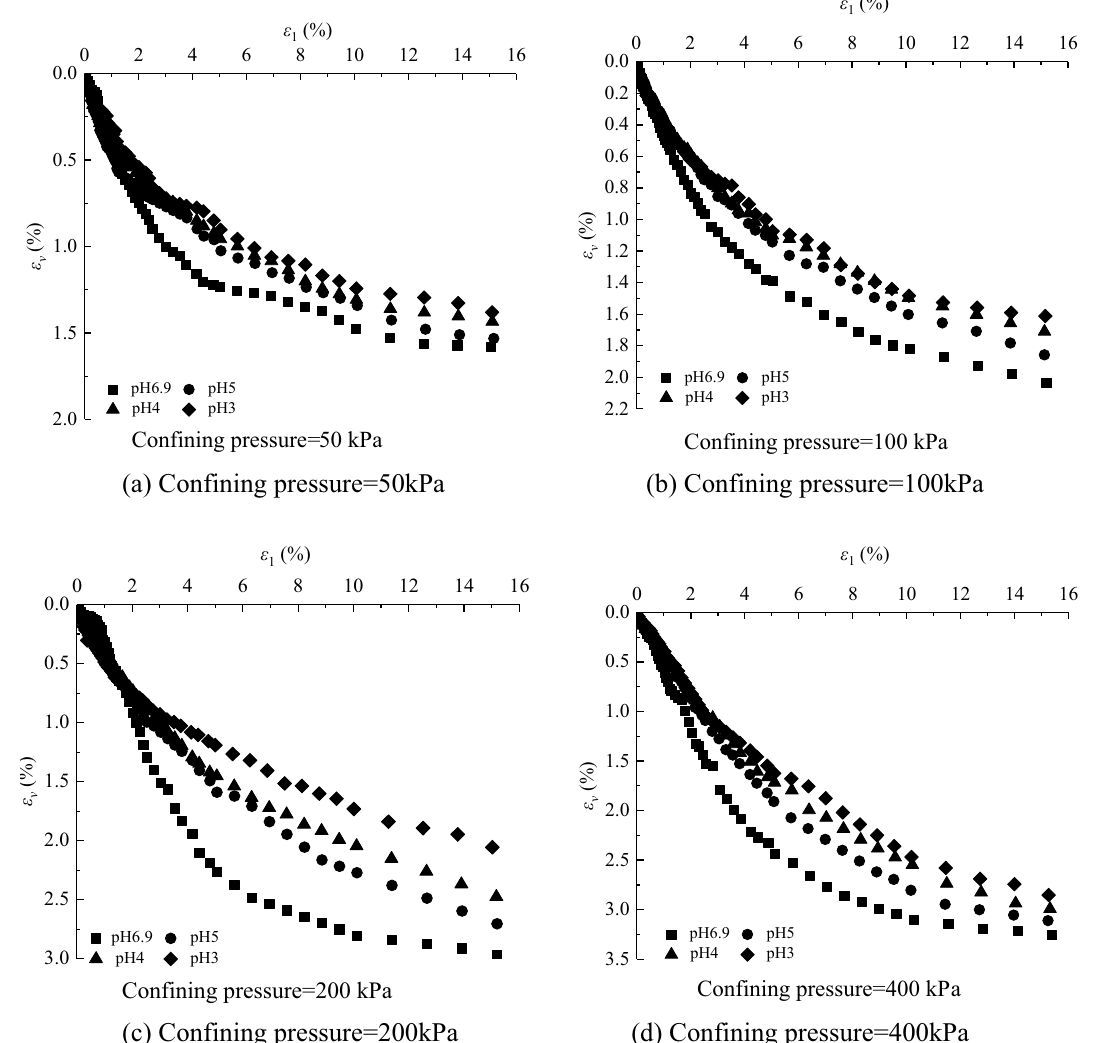
Figure 5. Experimental results of volumetric strain–axial strain curves of loess under different values of